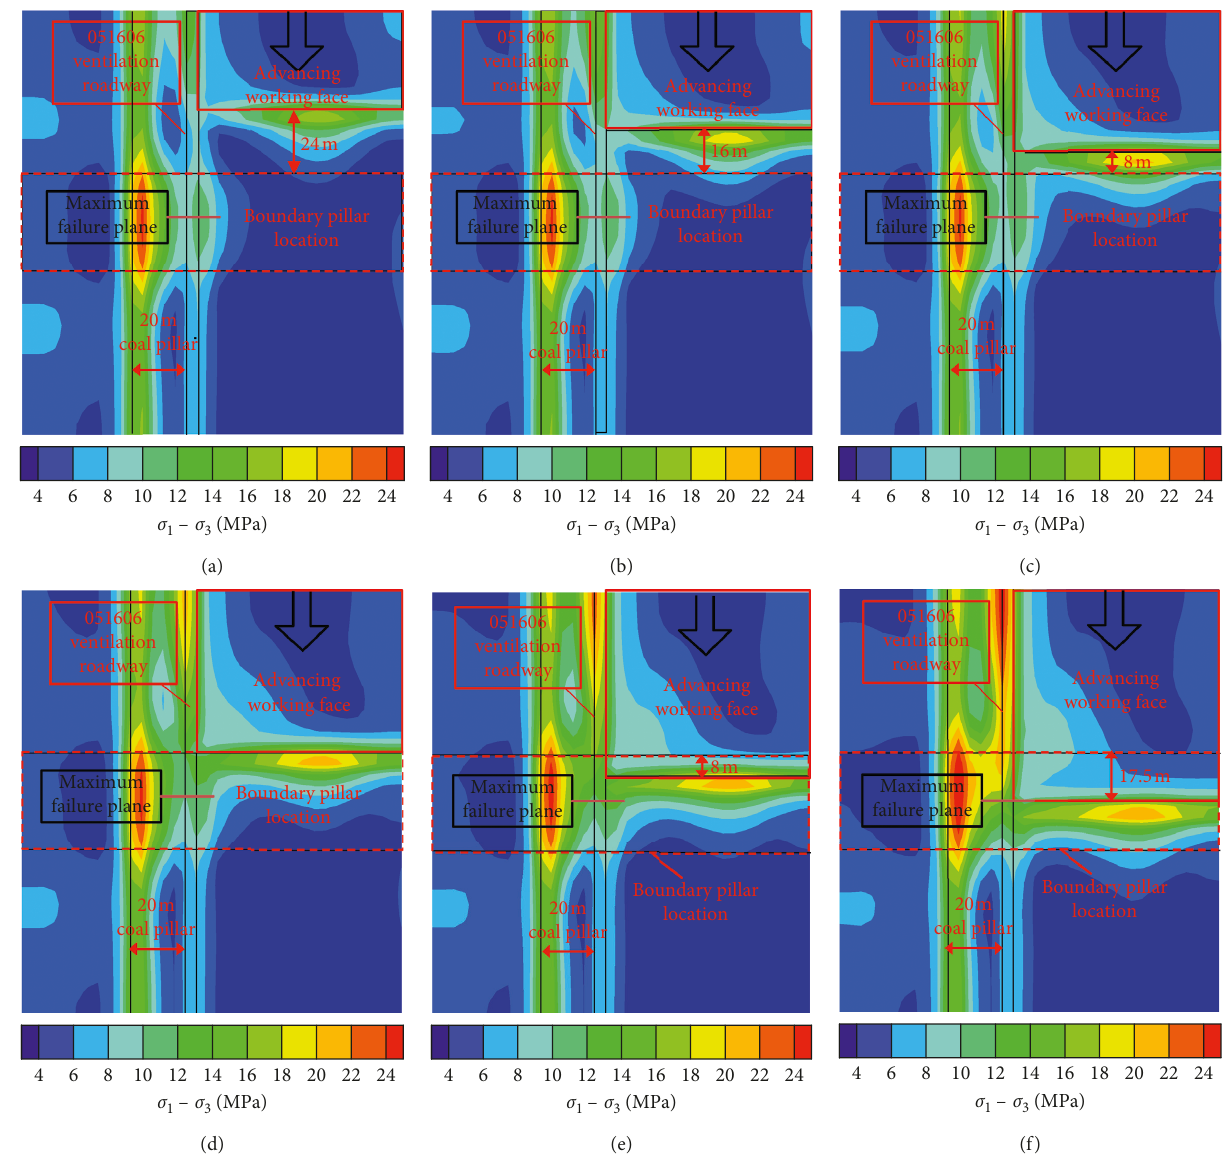
Figure 10: Stress state on rock surrounding vents while advancing the working face. (a) 24m from face end to pillar. (b) 16m from face end to pillar. (c) 8 m from face end to pillar. (d) 0m from face end to pillar. (e) − 8m from face end to pillar. (f) − 17.5m from face end to